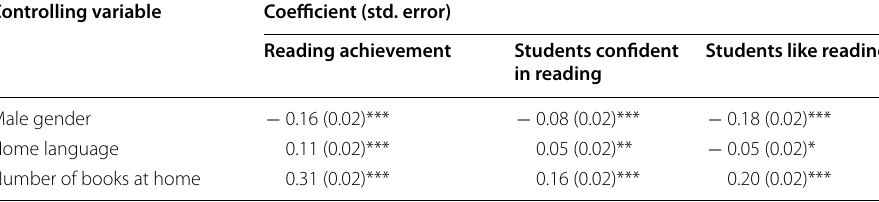
Table 2 Standardized regression coefficients of controlling variables in the path model for